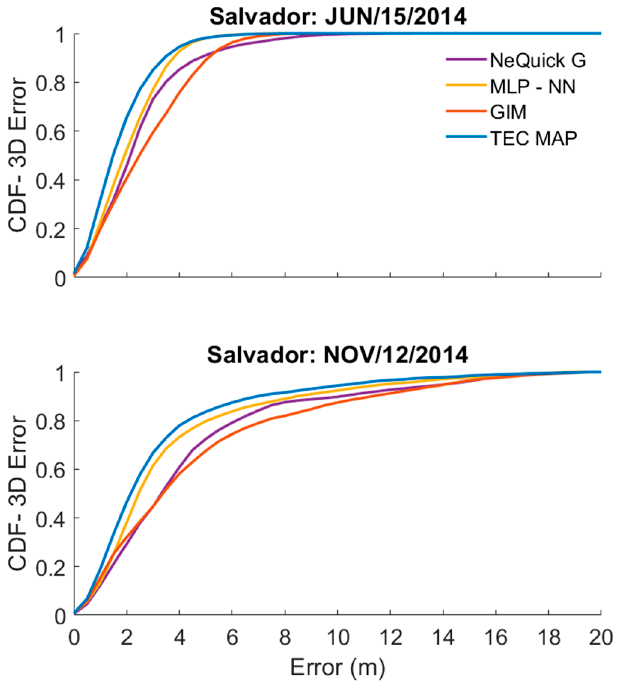
Figure 11. Empirical CDF of the SPP 3D error considering different ionospheric models for the sta- tion in Salvador for the winter (15 June at upper panels) and summer (12 November at bottom panel) solstice conditions in 2014.